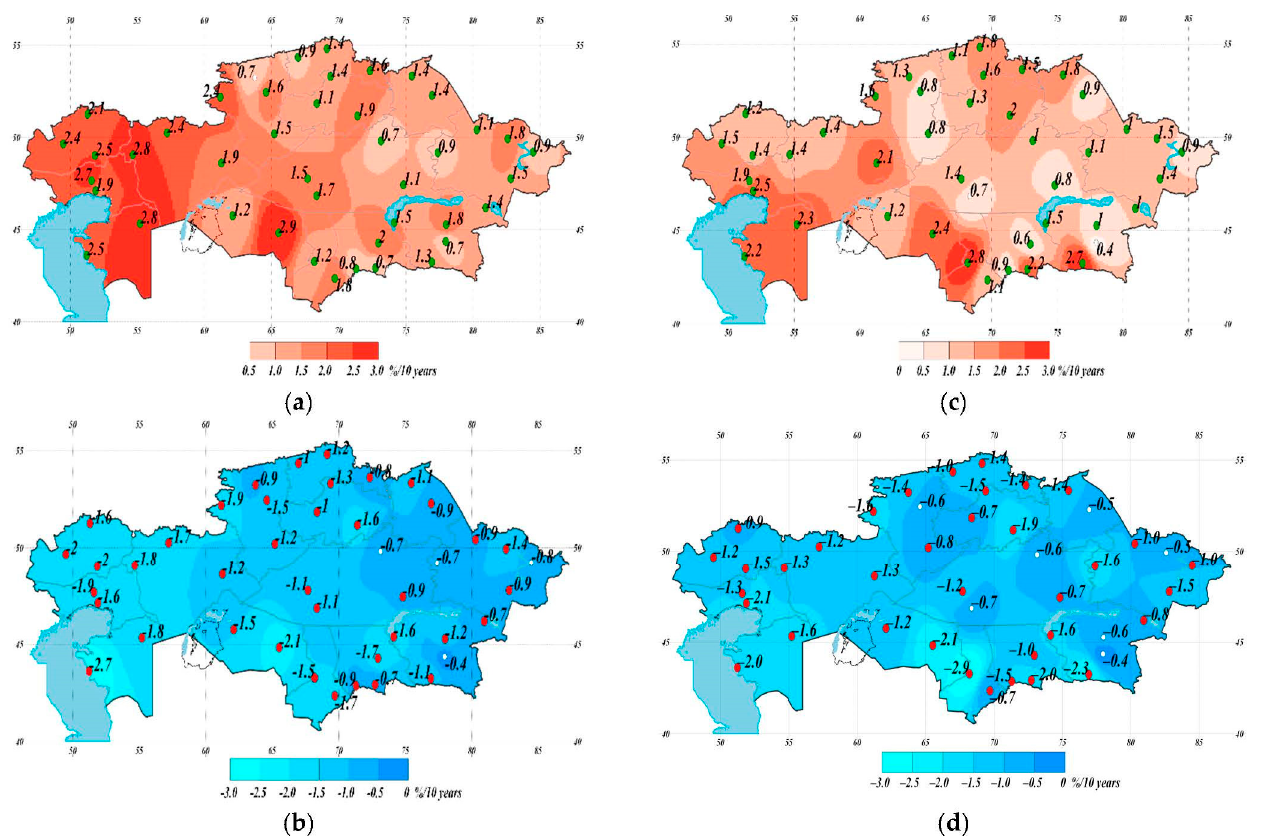
Figure 7. Spatial distribution of indices characterizing the proportion of extremely hot days TX90p ( a ) and warm nights TN90p ( b ), the proportion of non-hot days TX10p ( c ), extremely cold nights TN10p ( d ), and trends of these parameters for the period 1971–2020.